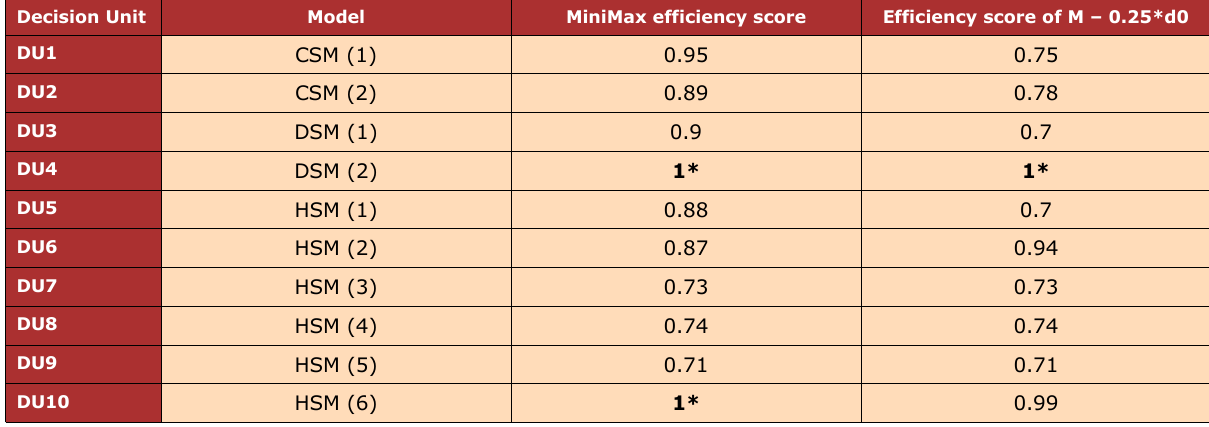
Table 20. Selecting the most efficient configuration for the setting with low interaction